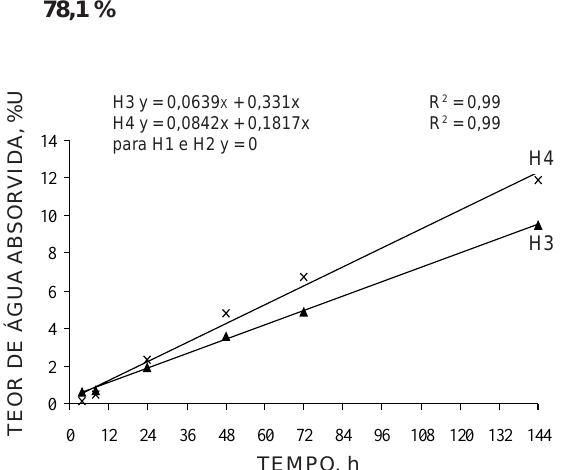
TEMPO, Figura 6. Valores médios de absorção de água (U%) pelas misturas de fertilizantes H3 e H4, considerando o tempo de exposição à umidade relativa de 69,5 %.